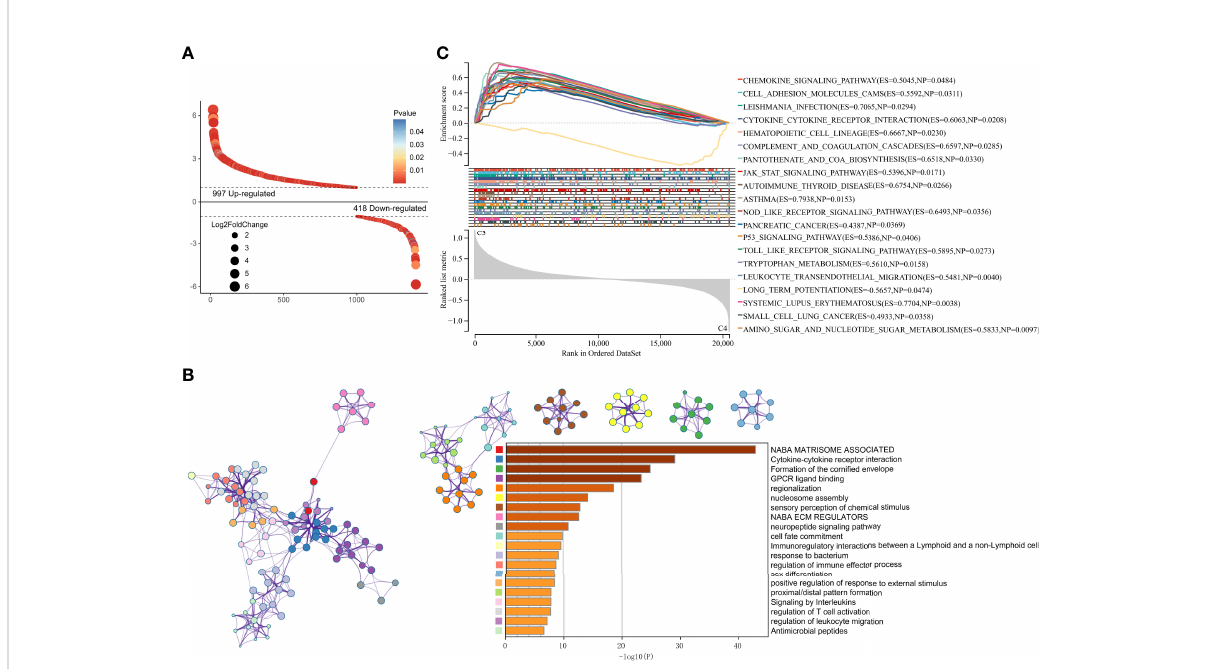
FIGURE 7 DEGs screening and enrichment Analysis. (A) Differentially expressed genes between cluster 3 and cluster 4. (B) GO analysis of the differentially expressed genes. (C) GSEA analysis of the differentially expressed genes.